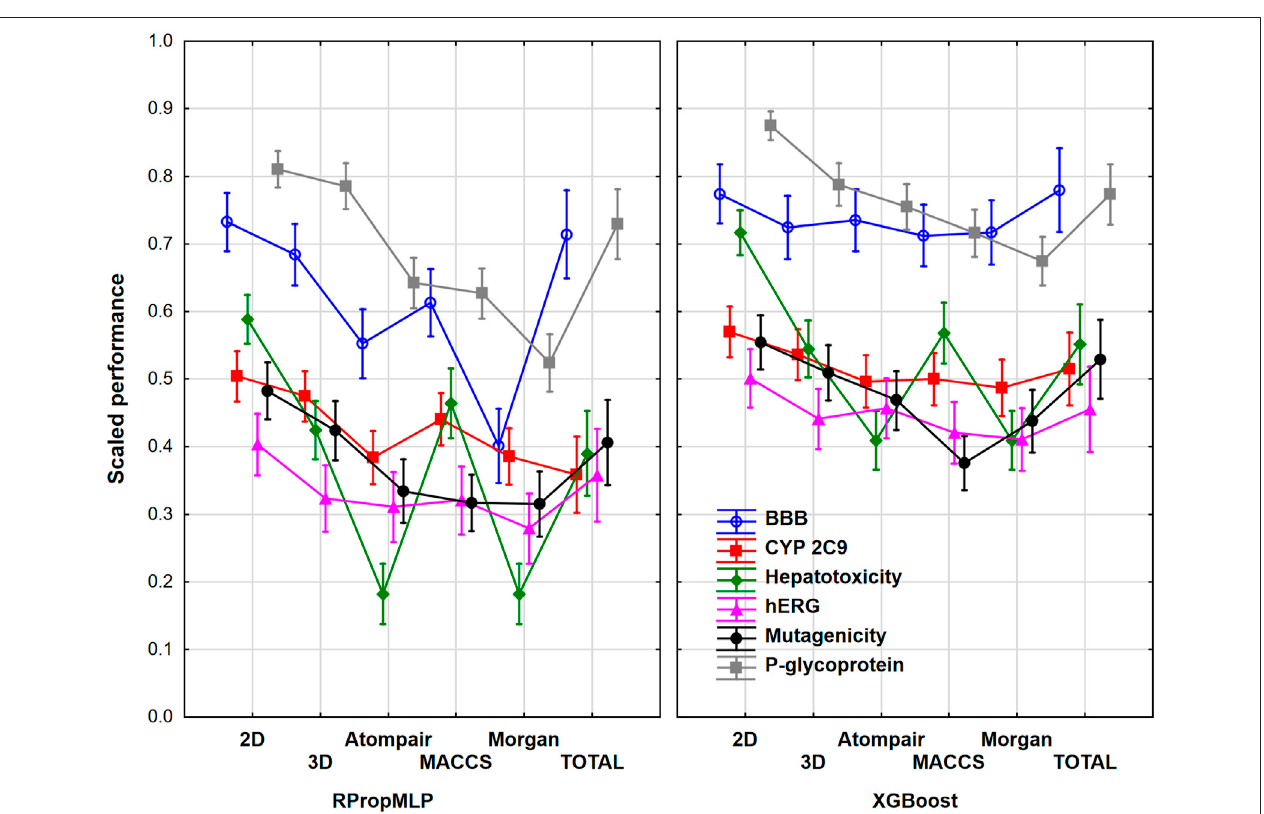
FIGURE 8 | Scaled performances based on machine learning algorithms and molecular descriptor sets for all the six datasets. The 18 performance parameters wererange-scaled between 0 and 1 and averaged acrossall models with the given descriptor types/ML algorithms/datasets. Thecase studies are plotted withdifferent colors. Mean of the scaled performance parameters and the 95% con fi dence intervals are presented for each case.